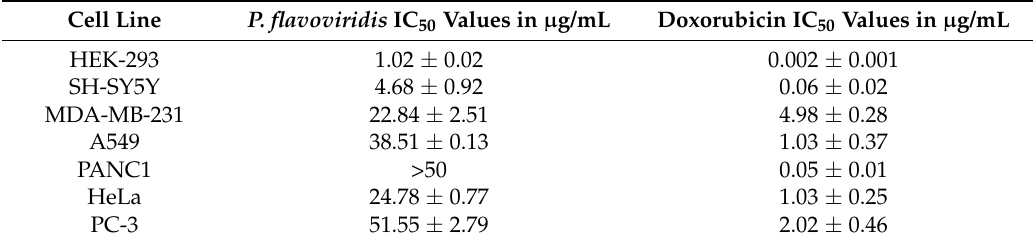
Table 3. IC 50 values of P. flavoviridis venom against human cell lines. The half maximal inhibitory concentrations (IC 50 in µ g/mL) were determined for the crude venom of P. flavoviridis against one non-cancerous (HEK-293) and six cancerous human cell lines. Error mean in ±